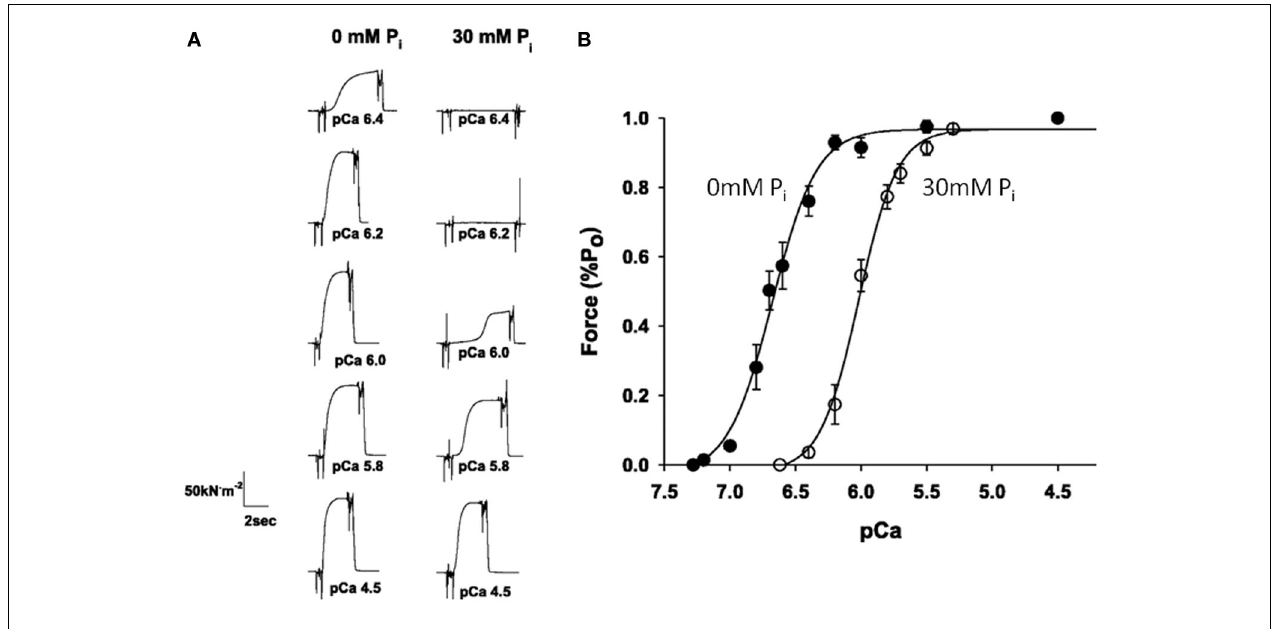
FIGURE 6 | Effect of P i on the force–pCa relationship. Skinned single fiber muscle forces measured at increasing concentrations of free Ca ++ (displayed in pCa, − log units) in the presence and absence of 30mM P i (A) .The forces are normalized to the maximum reached at